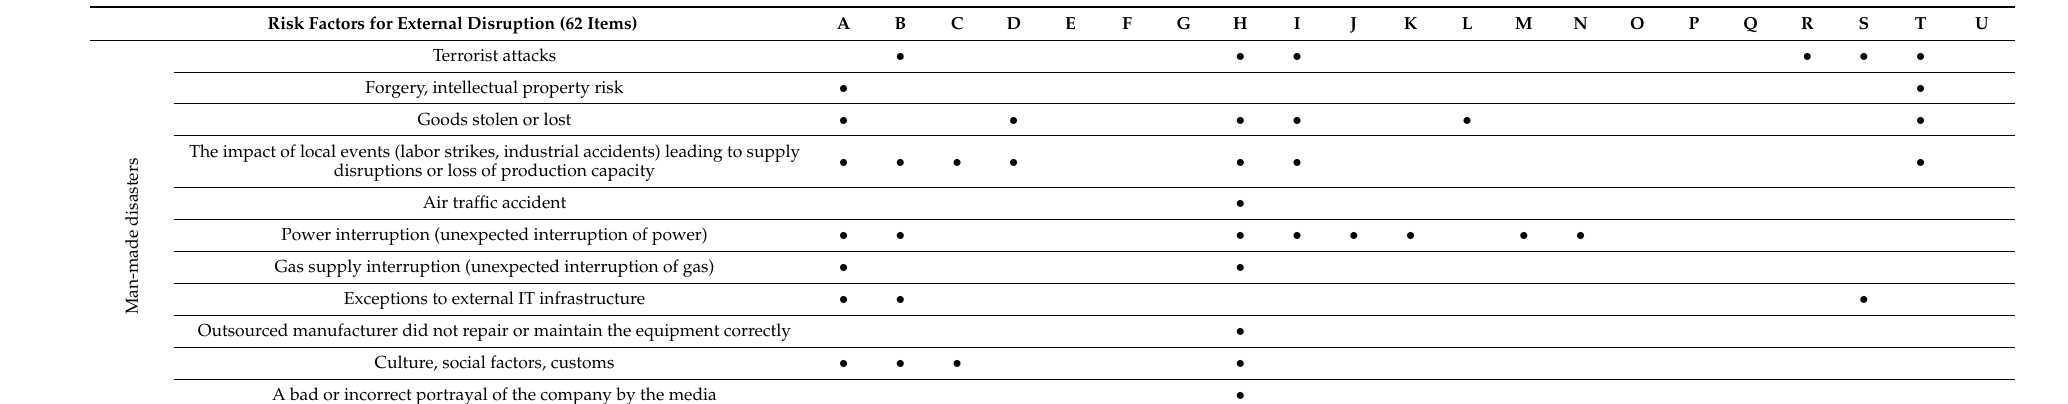
Table A2. Scholars have proposed external supply chain risk